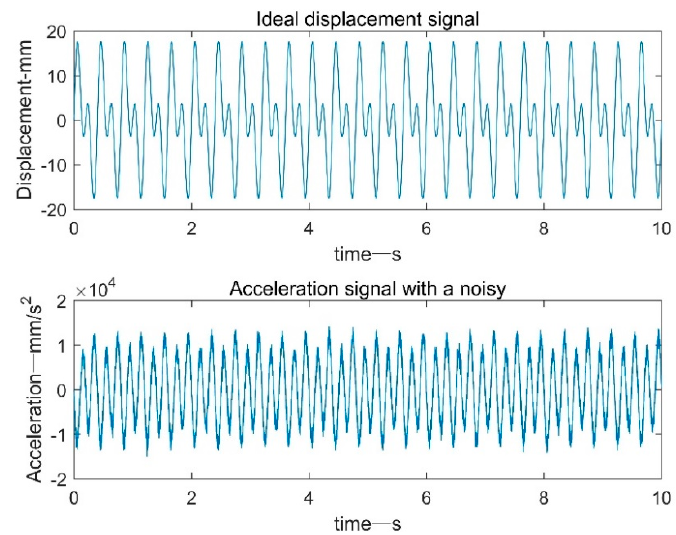
Figure 1. Acceleration signal diagram.